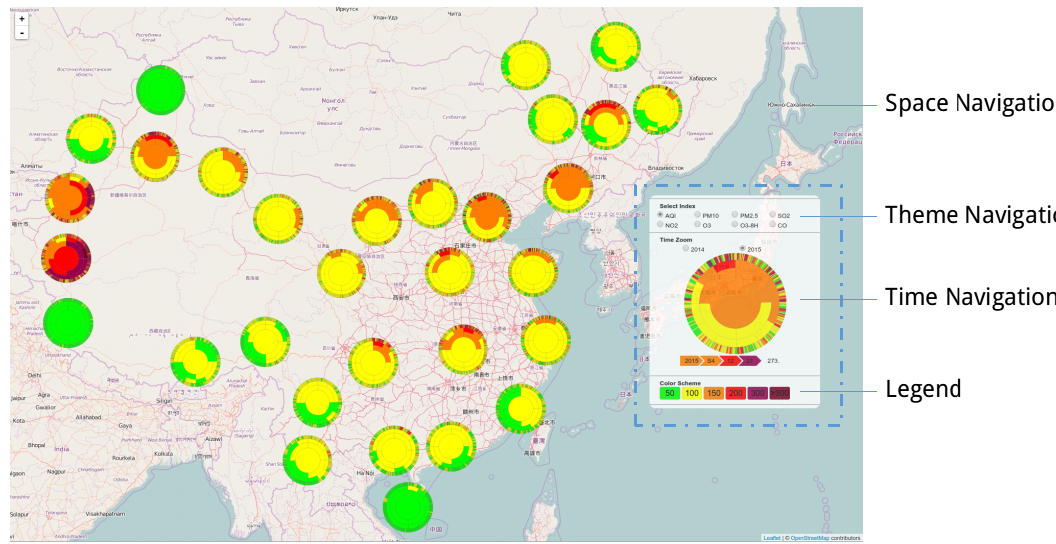
Figure 9. Initial view of the online air quality mapping application.